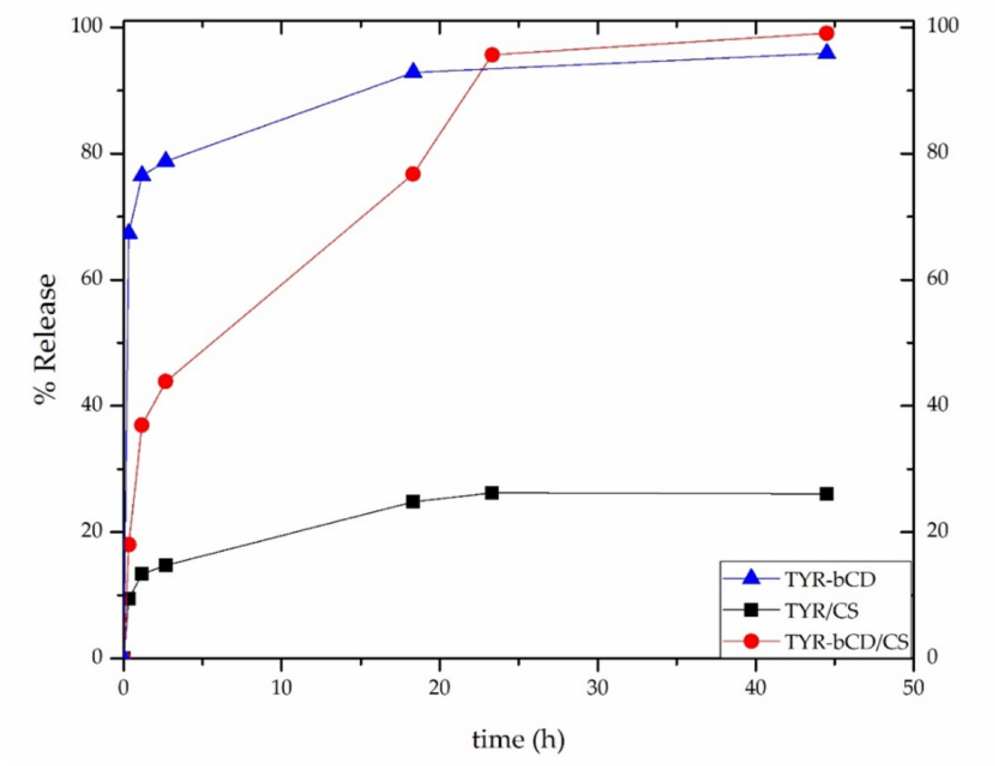
Figure 16. The release profile of tyrosol from TYR- β CD (blue line), TYR/CS (black line) and TYR- β CD/CS (red